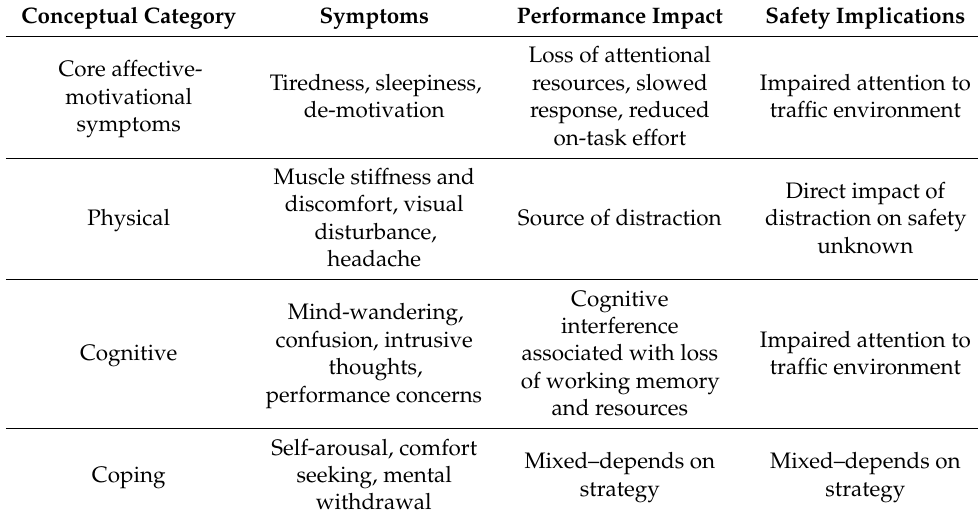
Table 1. Four conceptual elements of driver fatigue